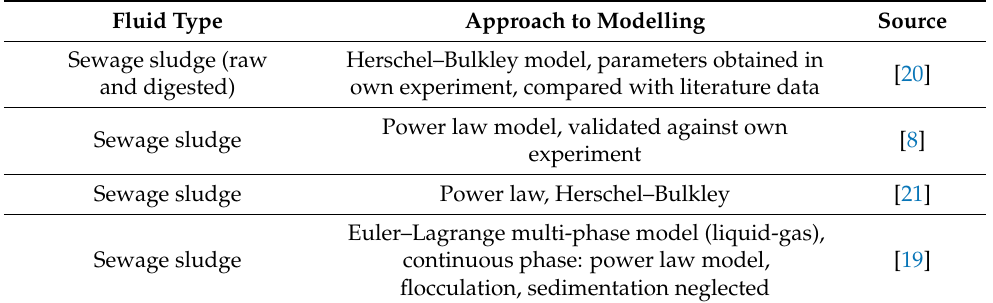
Table 2. Approaches to pseudoplastic flow